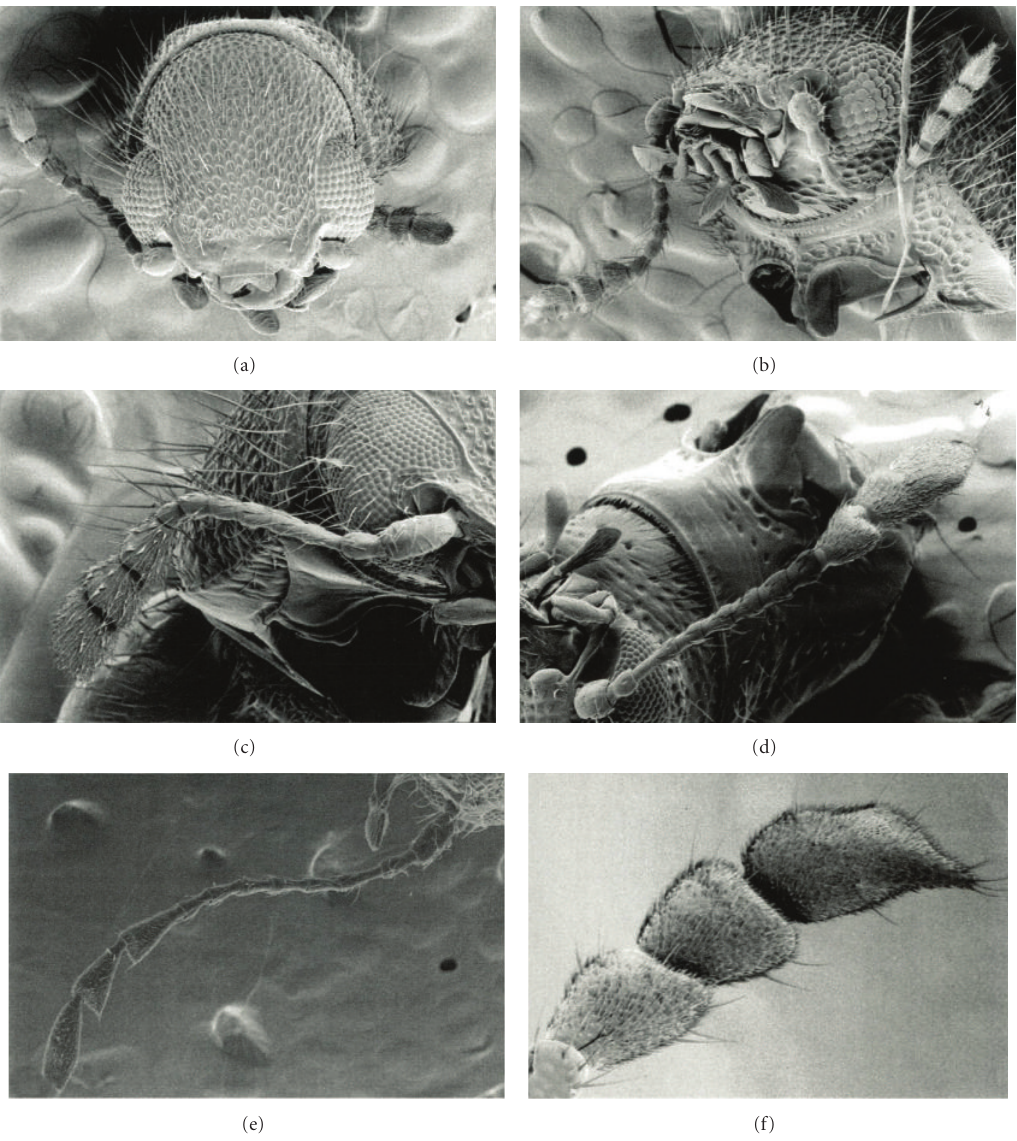
Figure 21: Various organs. (a, b) Thriocerodes bifasciatus ((a) head, (b) mouthparts). (c) Thriocera pectoralis antenna. (d) Tarsostenus univttatus antenna. (e) Riotenerus fossipenneus antenna. (f) Fallopylus pallipes capitulum. shallow linear glabrous elevations, and the elytra are devoid of 2 ◦